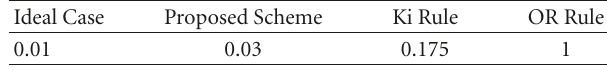
Table 3: False Alarm Rate (when detection rate =